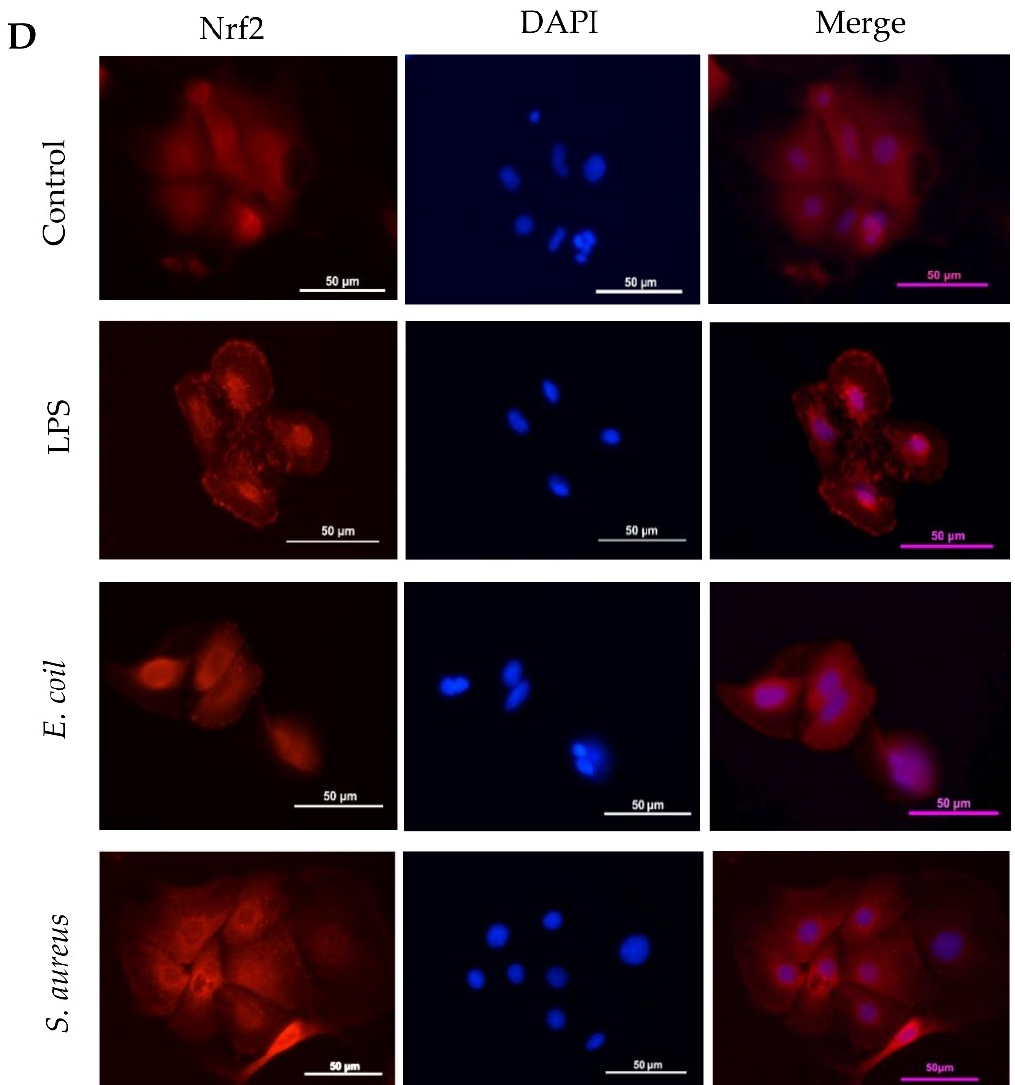
Figure 5. Response of Nrf2 pathway to E. coli and S. aureus . ( A , B ) pbMECs were treated with heat-killed E. coli (1 × 10 7 particles/mL) ( A ) and S. aureus (1 × 10 7 particles/mL) ( B ), respectively, for the indicated time. Nqo-1 and Gclm mRNA expression was quantified by qPCR. Fold change is relative to control cells. Data are means ± s.d. of three triplicates and are representative of 3 separate experiments. ( C ) Cytoplasmic and nuclear proteins extracted from cells treated with E. coli (1 × 10 7 particles/mL), S. aureus (1 × 10 7 particles/mL) and lipopolysaccharides (LPS) (10 µ g/mL) were analyzed by immunoblotting with anti-Nrf2. GADPH and Histone are shown as loading controls, respectively. Nuclear Nrf2 protein levels were determined with densitometry analyses after normalization to Histone. Bars are means ± s.d. of three triplicates and are representative of 3 separate experiments. * p < 0.05. ( D ) After treatment with E. coli , LPS or S. aureus for 12 h as described above, cells were subjected to immunofluorescent staining. Nrf2 was stained with an Alexa Fluor 594-conjugated secondary antibody. Cell nuclei were visualized by 4 ′ ,6-Diamidino-2-phenylindole dihydrochloride (DAPI). The images were obtained using inverted fluorescence microscopy.